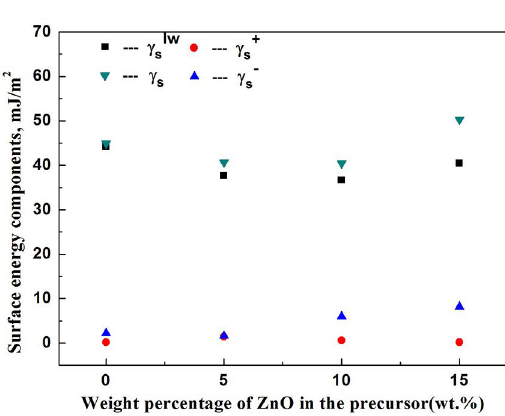
Figure 2. Surface energy as function of ZnO content in coating